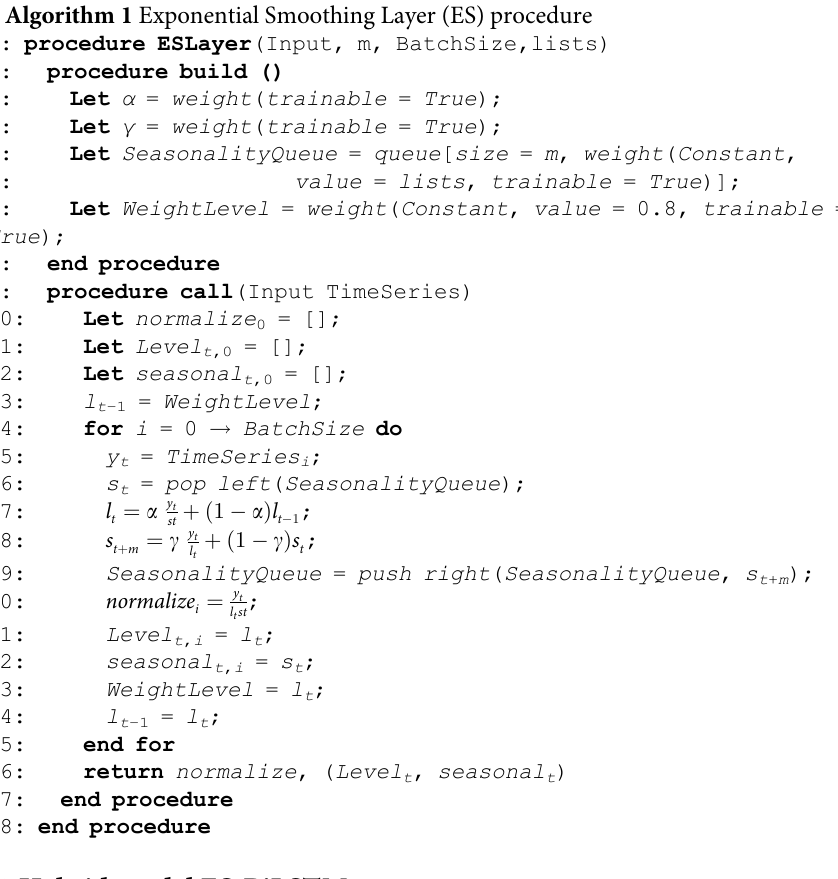
Algorithm 1 Exponential Smoothing Layer (ES)